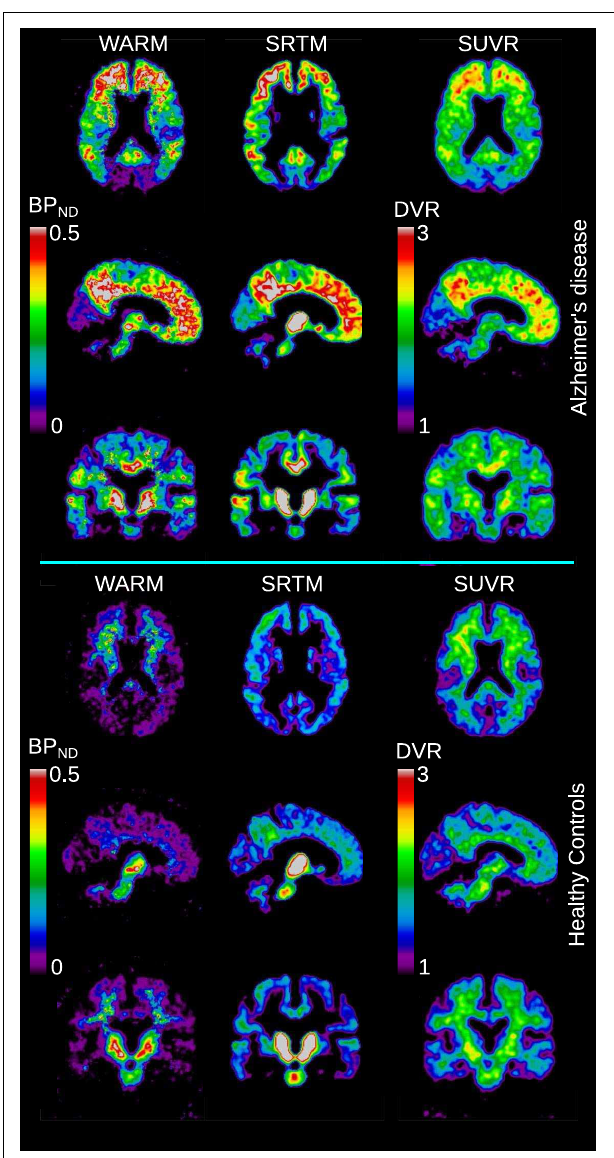
FIGURE 4 | Images of [ 11 C ] PIB binding in brain. Upper three rows show mean binding images of sections of the brains of a group of AD patients ( N = 6), and lower three rows show similar sections for age-matched healthy controls ( N = 8). For each group is shown the BP ND values derived from the WARM and SRTM methods. For the SUVR method, the mean DVR measures are illustrated in the range 1–3.